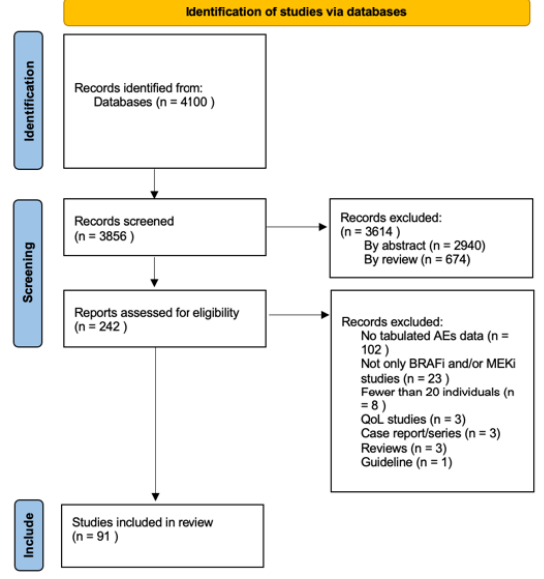
Figure 1. PRISMA flow chart of study inclusion process [113]. Cancers 2023 , 15 , 141